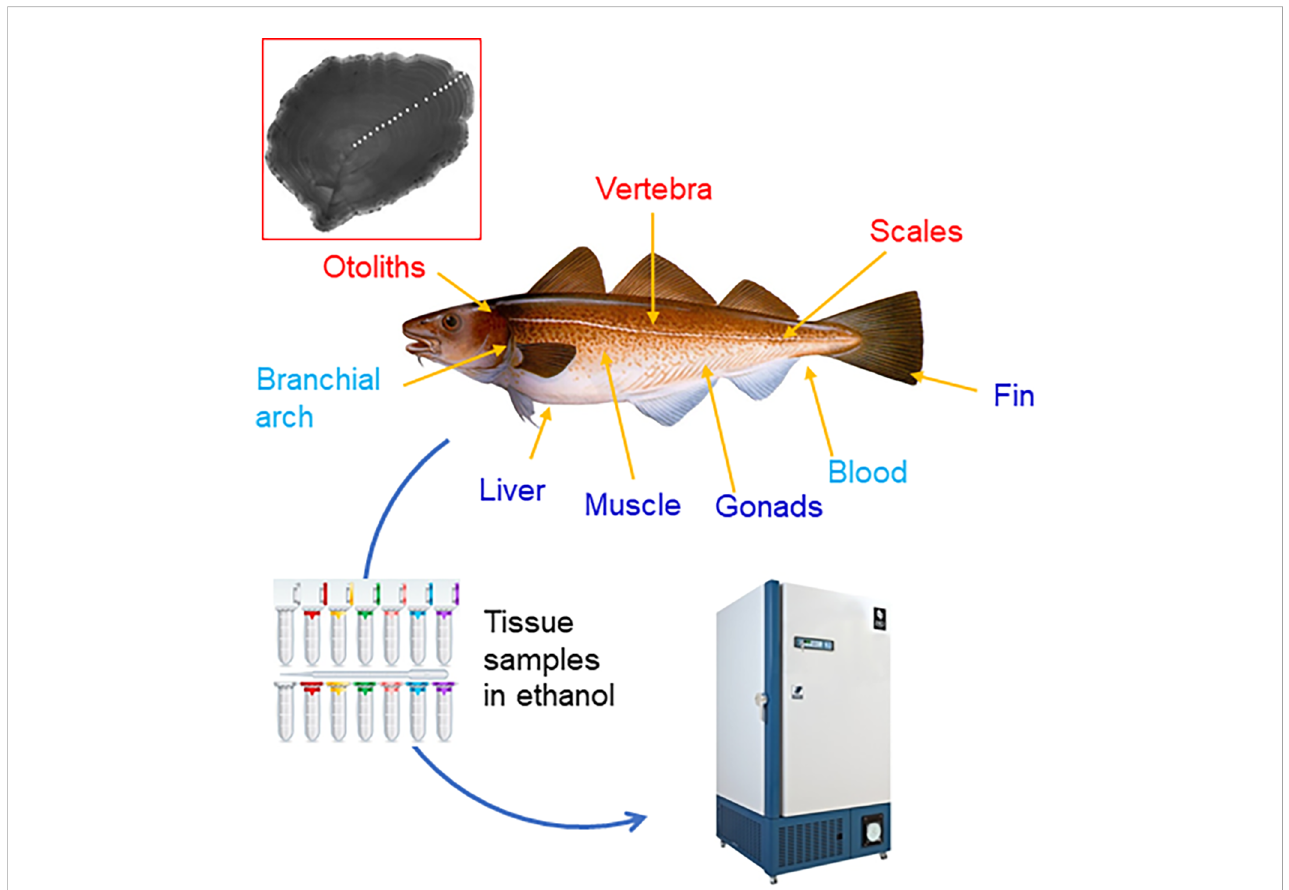
FIGURE 1 Hard structures traditionally used to estimate age in fi sh (names above the fi sh fi gure and in red), particularly otoliths (insert); and tissues either already used (names below the fi sh fi gure in dark blue) or with potential use (light blue) to develop epigenetic clocks. Fin clips are the preferred choice because they are easy to access and collect, and represent a non-invasive and non-lethal technique. Insert: the otolith image corresponds to yellow fi n fl ounder, aged 19 years. The annual increments are marked by white dots. Source: Wikimedia